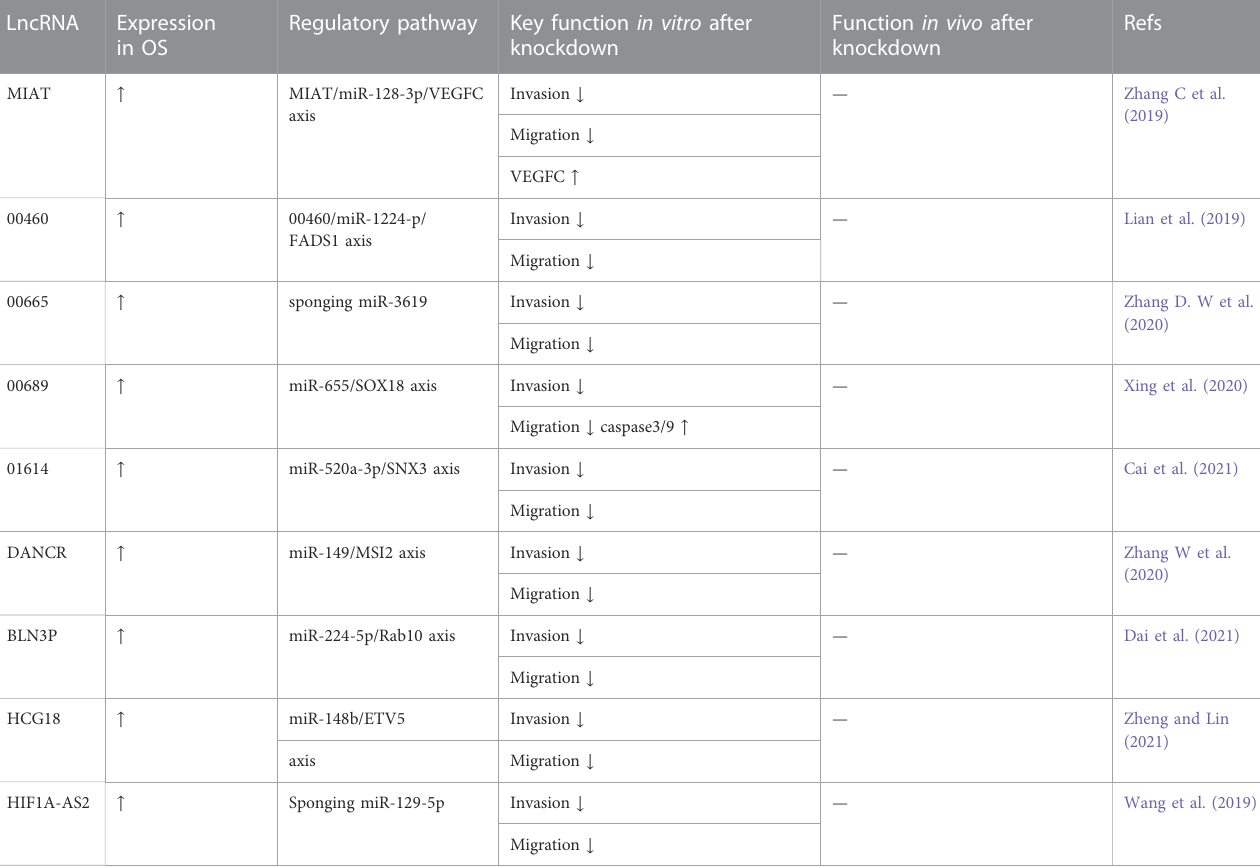
TABLE 4 Oncogenic lncRNAs associated with osteosarcoma invasion and